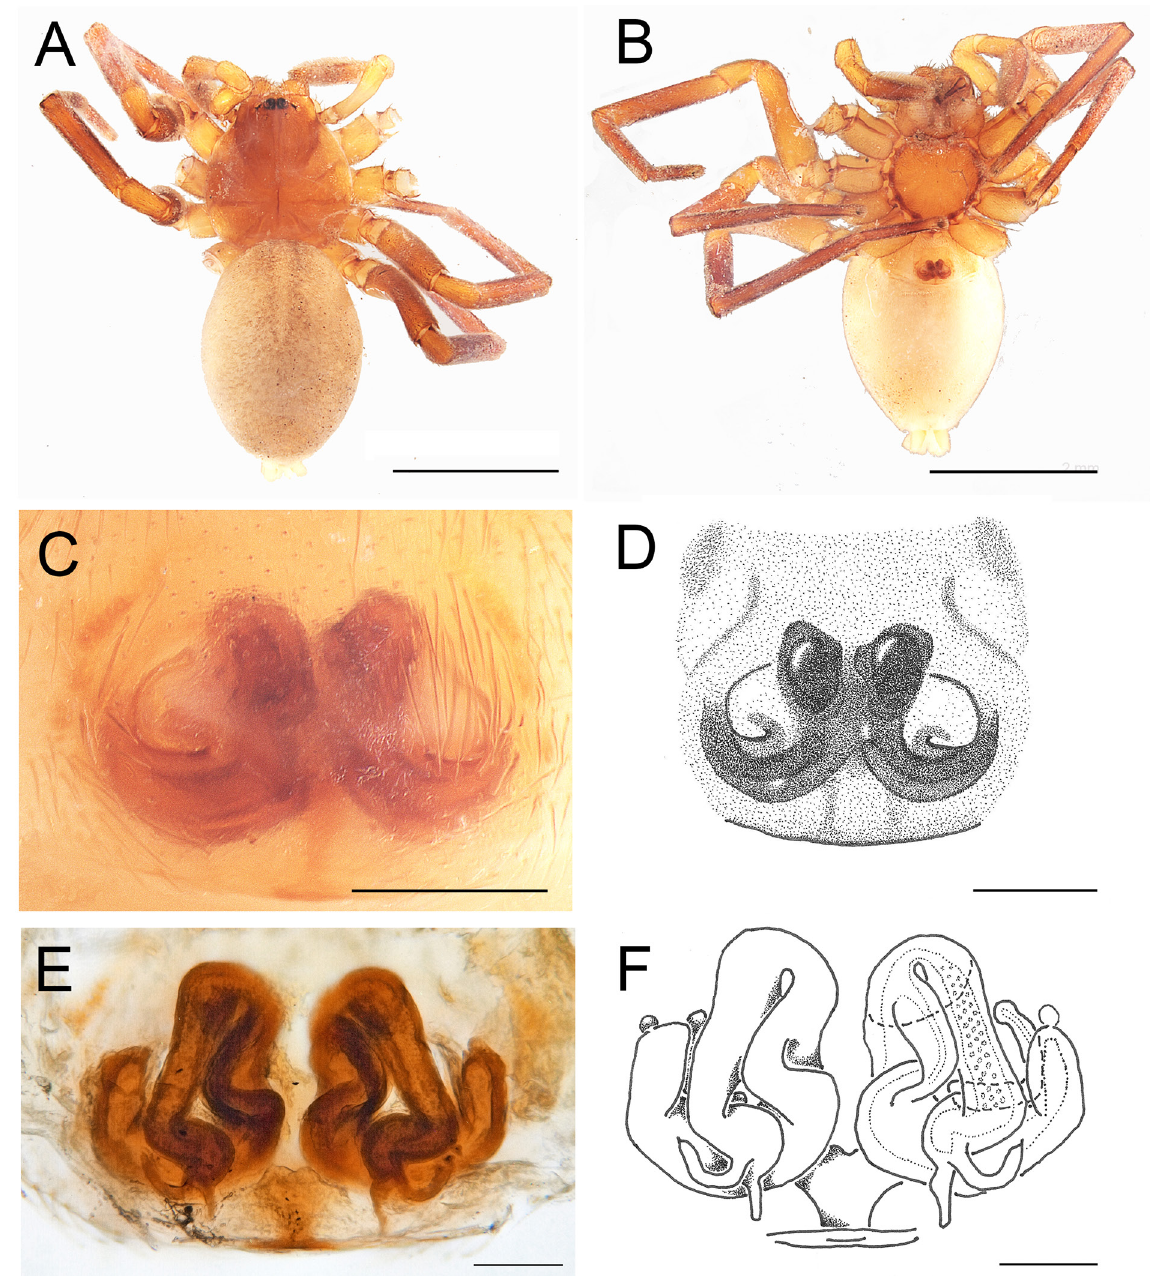
Fig. 23. Andromma elephantactes sp. nov., ♀, holotype (BE_RMCA_ARA.Ara 201034). A . Habitus, dorsal view. B . Same, ventral view. C–D . Epigyne, ventral view. E–F . Same cleared, dorsal view. Scale bars: A–B = 2 mm; C–D = 0.2 mm; E–F =